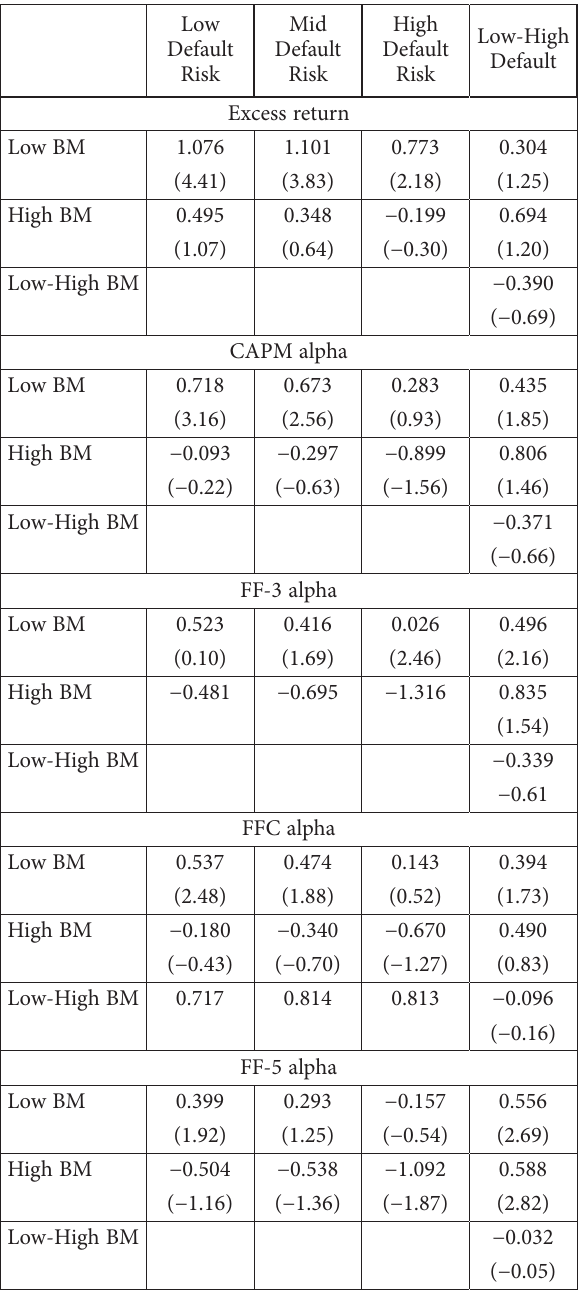
Table 4. Default risk premium and book-to-market